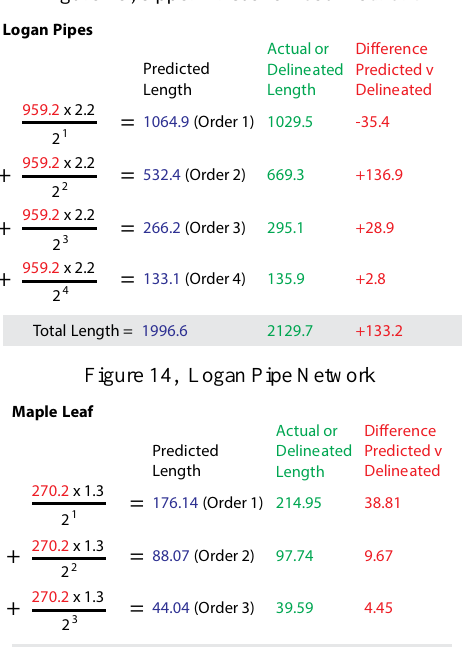
Figure 13, Upper Brisbane Road Network